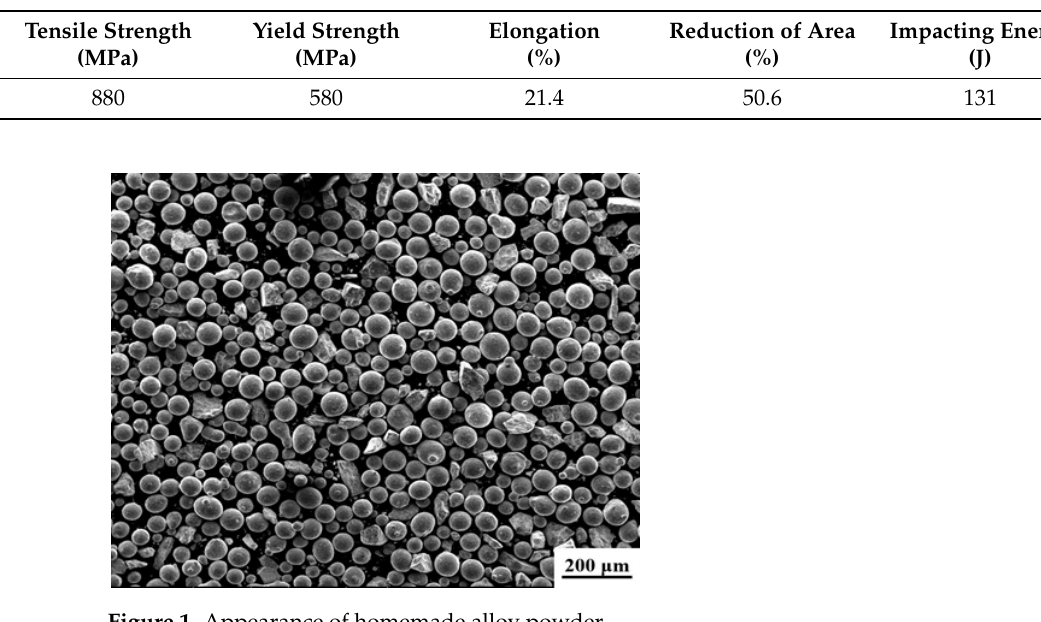
Figure 1. Appearance of homemade alloy powder.